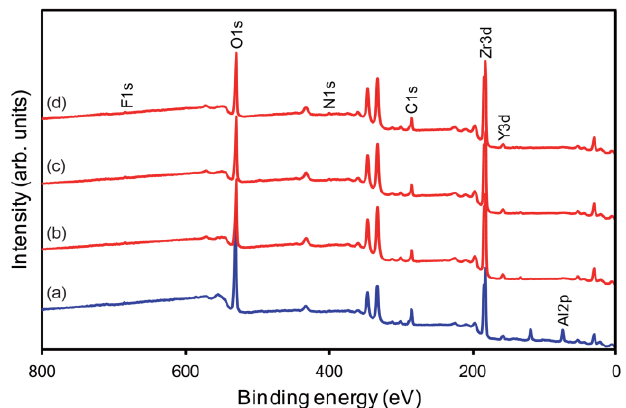
Figure 5. Wide-scan X-ray photoelectron spectroscopy (XPS) spectra in the range from 0 to 800 eV: ( a ) APA; ( b ) 10F30; ( c ) 20F30; ( d ) 30F30. Al: aluminum; C: carbon; F: fluorine; N: nitrogen; O: oxygen; Y: yttrium; Zr: zirconium.